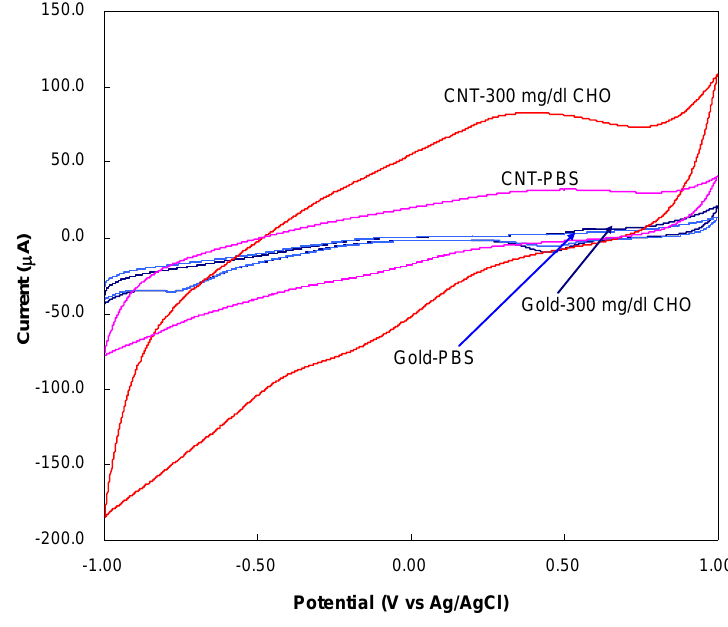
Figure 5. Cyclic voltammograms for gold and CNT based cholesterol bioprobe at 300 mg/dL concentration and 100 mV scan rates